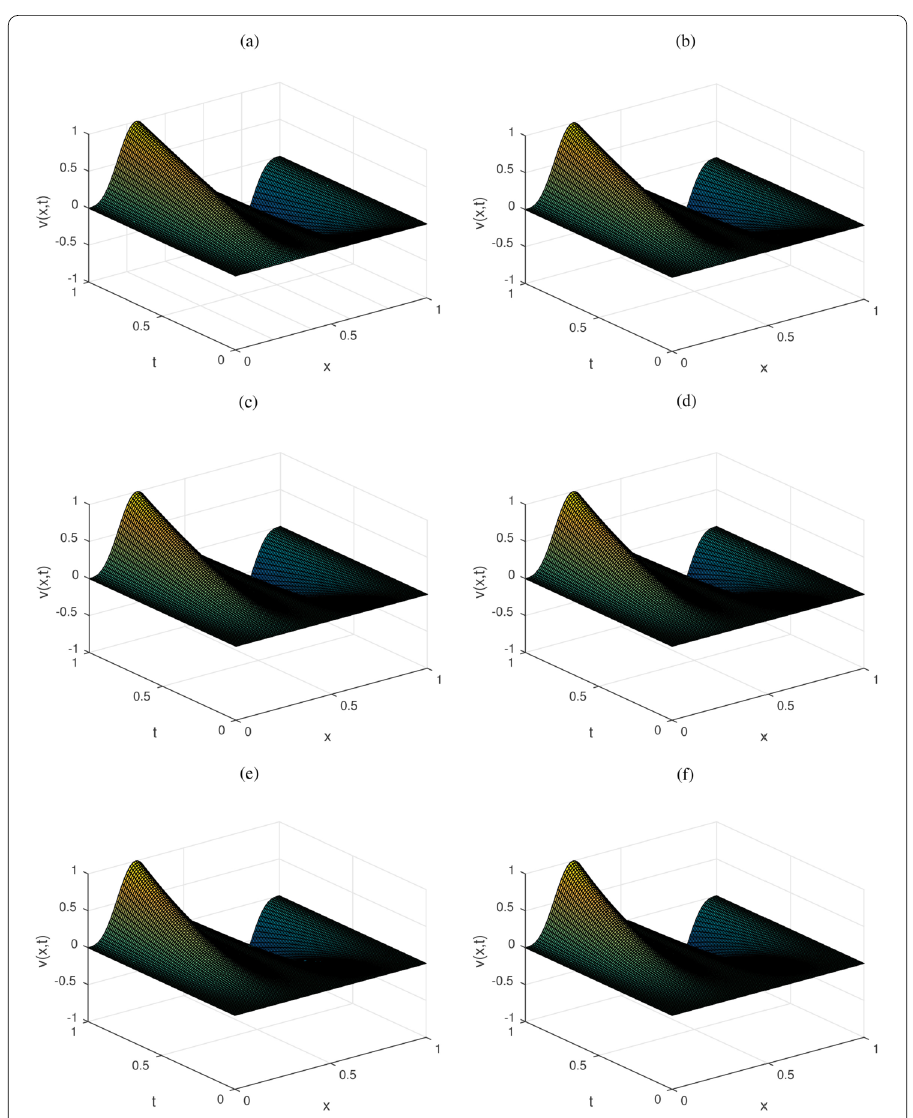
Figure 2 Approximate solution of the problem (1) with reaction function (61) using the DM method, with differentiation order ( a ) α = 1.01, ( b ) α = 1.2, ( c ) α = 1.4, ( d ) α = 1.6, ( e ) α = 1.8, and ( f ) α = 2. The solutions were calculated over Ω = (0,1), and using K = 0.1 and T = 1. Computationally, we let h = τ =